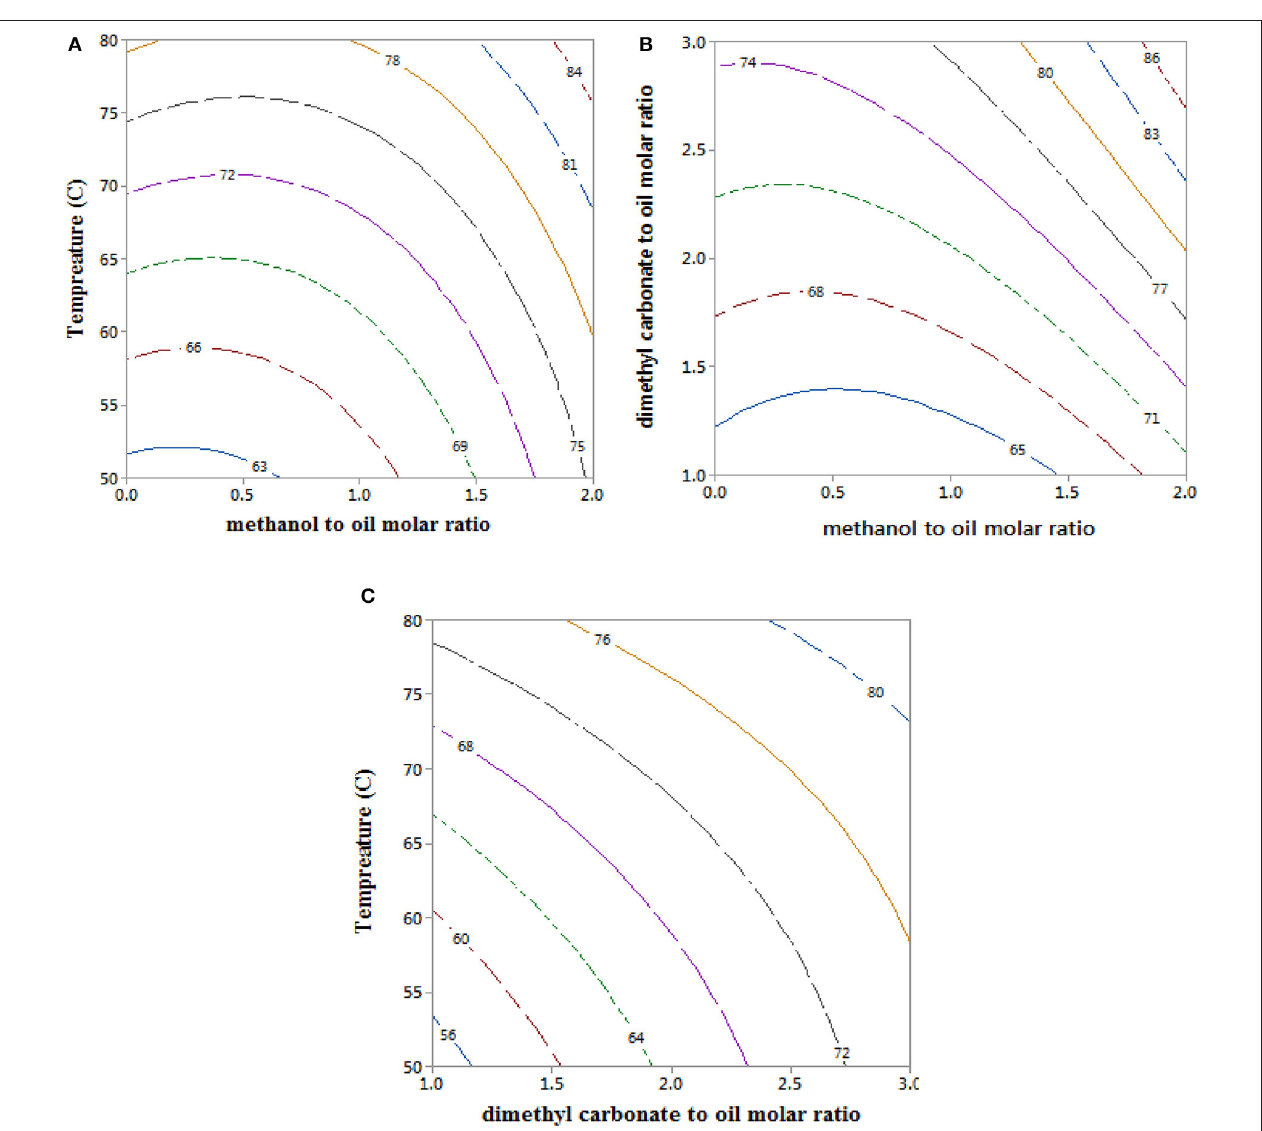
FIGURE 3 | Contour plots for the effect of DMC, methanol, and temperature on the GLC yields for reactive coupling of RSO transesterification with in situ crude glycerol valorisation to GLC. (A) Interaction between temperature and MeOH at 2 DMC, (B) interaction between DMC and MeOH to RSO molar ratio at 65 ◦ C and (C) interaction between temperature and DMC at 1